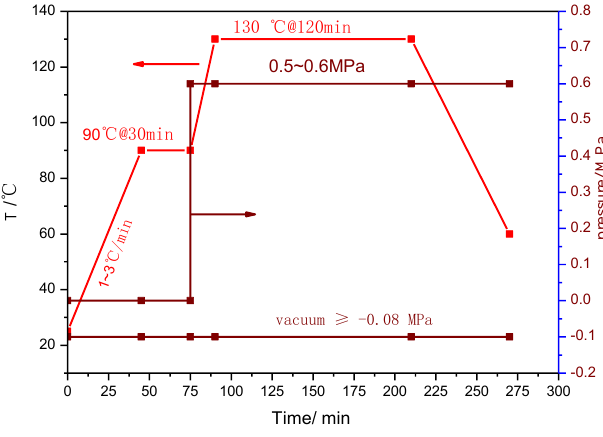
Figure 3. Process parameters for the curing of AGMP3600 prepreg in an autoclave. Table 1. Mechanical properties of AGMP3600/EW250F (glass fabric, 8 satin, 47 vol %), a rosin-sourced epoxy laminates, and of 3233B/EW250F, a standard intermediate-temperature epoxy laminate for reference and comparison.